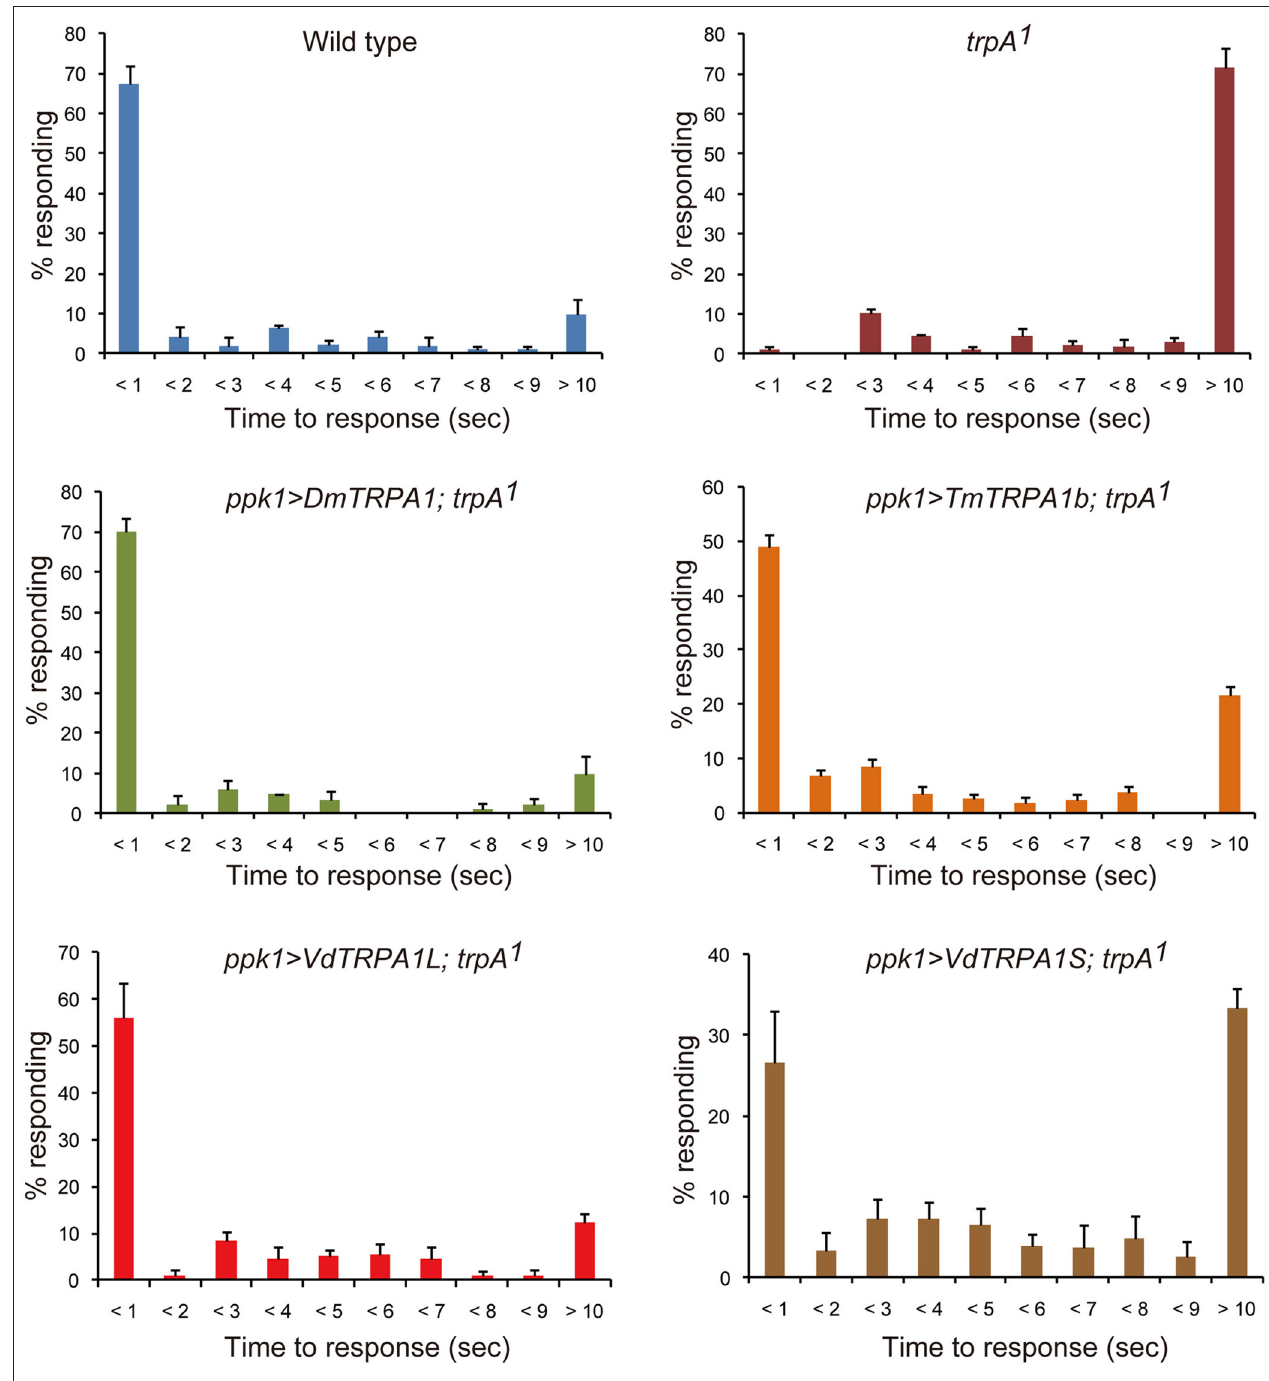
FIGURE 3 | VdTRPA1L and TmTRPA1b are able to complement the functions of DmTRPA1 for thermal nociception behavior of Drosophila melanogaster larvae. Wild type ( n = 92), trpA11 ( n = 90), and trpA1 1 expressing either DmTRPA1 (ppk1 > DmTRPA1; trpA1 1 , n = 83), VdTRPA1L (ppk1 > VdTRPA1L; trpA1 1 , n = 124), VdTRPA1S (ppk1 > VdTRPA1S; trpA1 1 , n = 139), or TmTRPA1b (ppk1 > TmTRPA1b; trpA1 1 , n = 162) under ppk1.9-Gal4 were tested for their response to high temperature using 46 ◦ C probe. The percentage of responding larvae for each genotype is shown at each second within 9s and over 10s (mean value ± SEM). p -values for trpA1 1 and trpA1 1 expressing VdTRPA1S compared to wild type are < 0.02 and < 0.03, respectively. p -values for wild type and trpA1 1 expressing DmTRPA1 are < 0.02, and P -values for trpA1 1 expressing either VdTRPA1L, VdTRPA1S, or TmTRPA1b are < 0.03 compared to trpA1 1 .